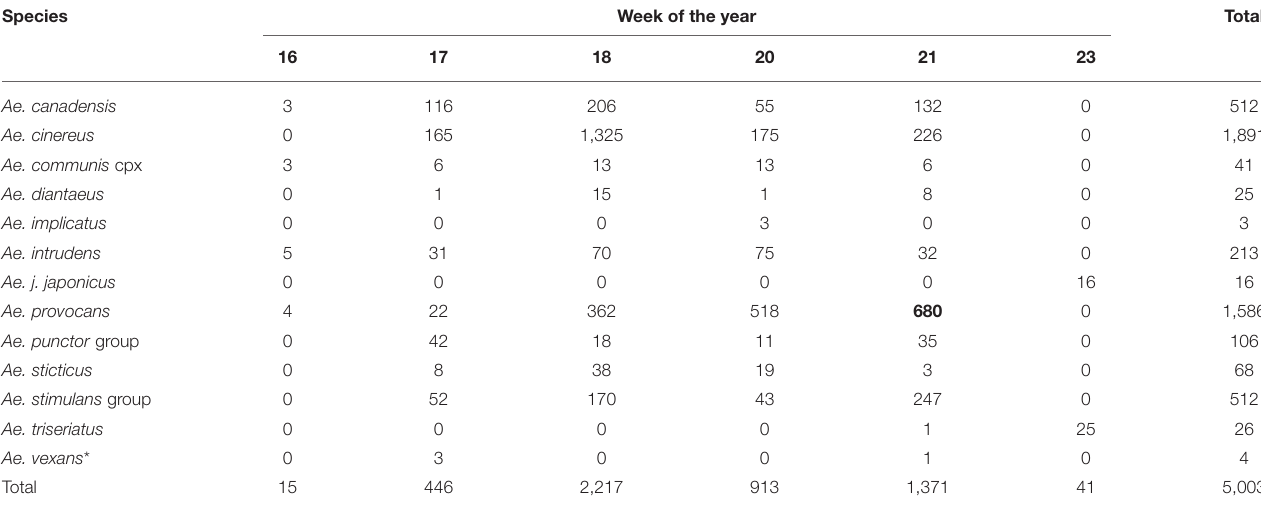
TABLE 1 | Total number of immature and newly emerged mosquitoes collected during epidemiological weeks 16–23 2019 in Sawyer and Washburn Counties, WI, U.S.A. Species